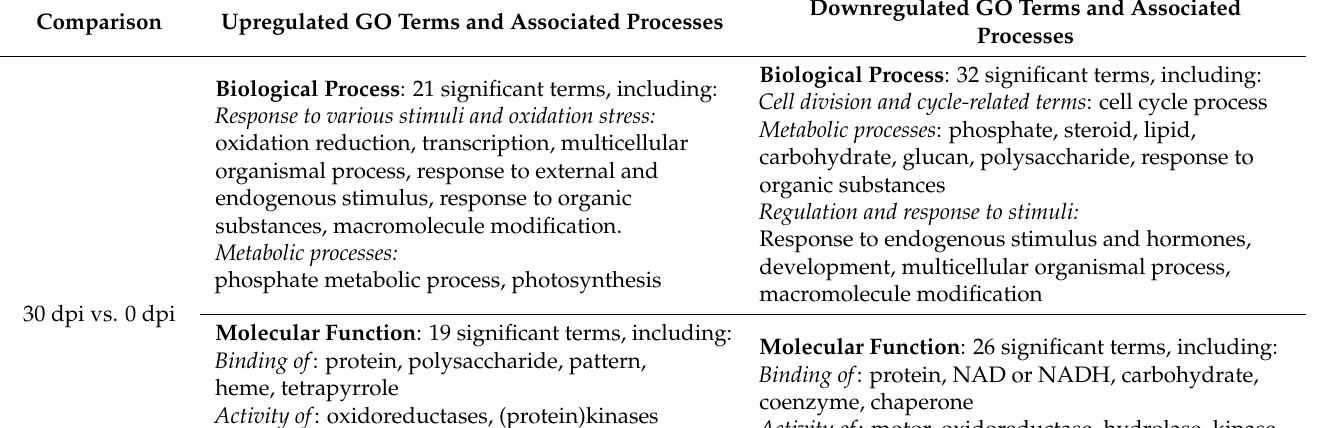
Table 3. GO terms and their associations (see also Figures S5 and S6). Downregulated GO Terms and Associated Comparison Upregulated GO Terms and Associated Processes